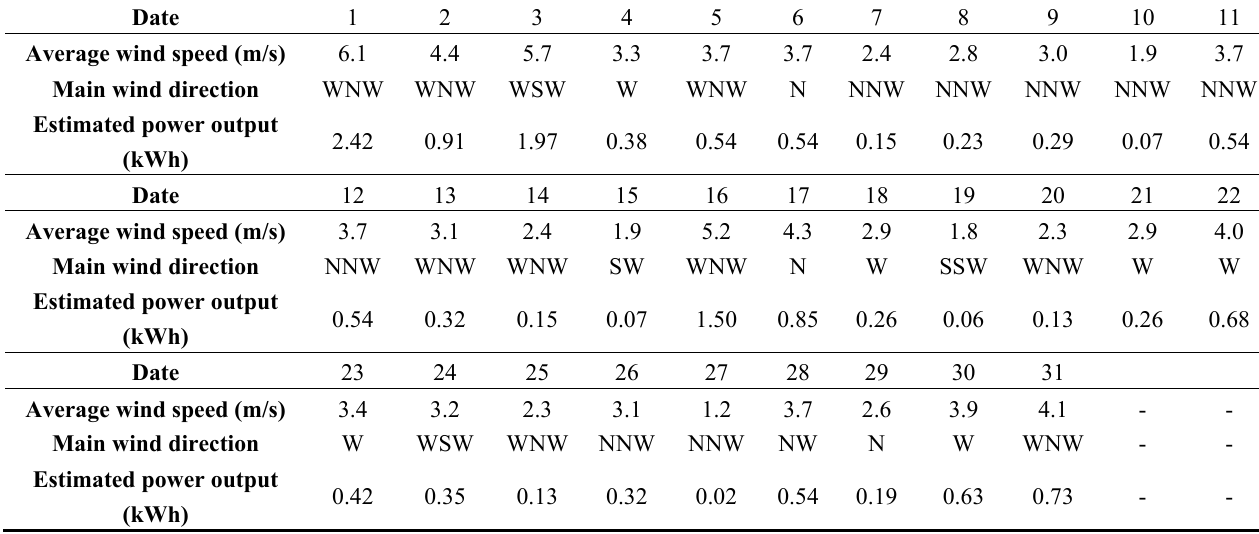
Table A12. Estimated power output per day in